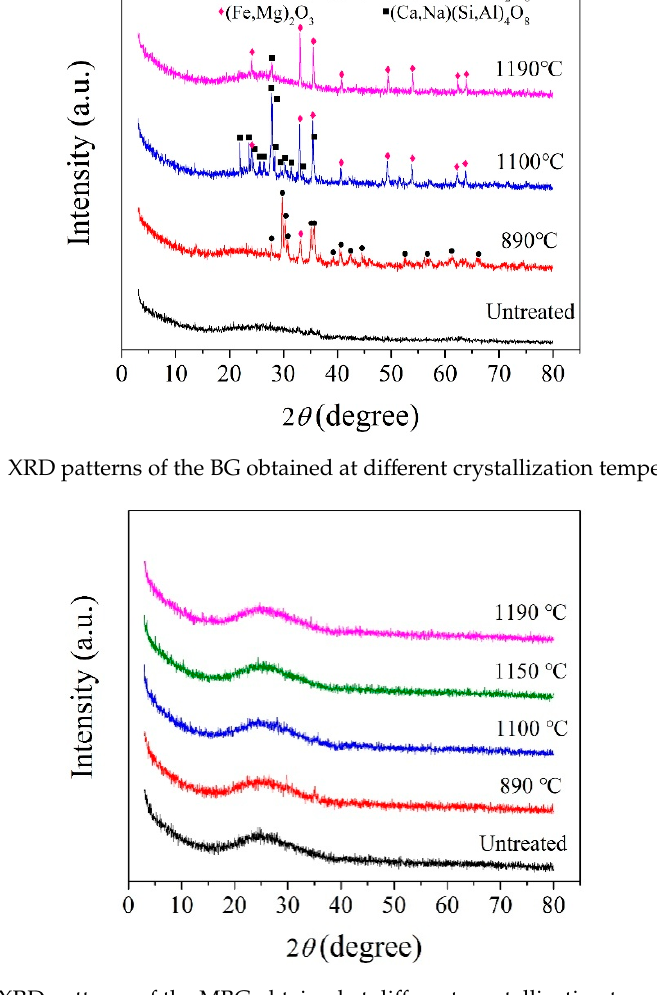
Figure 6. XRD patterns of the MBG obtained at different crystallization temperatures.